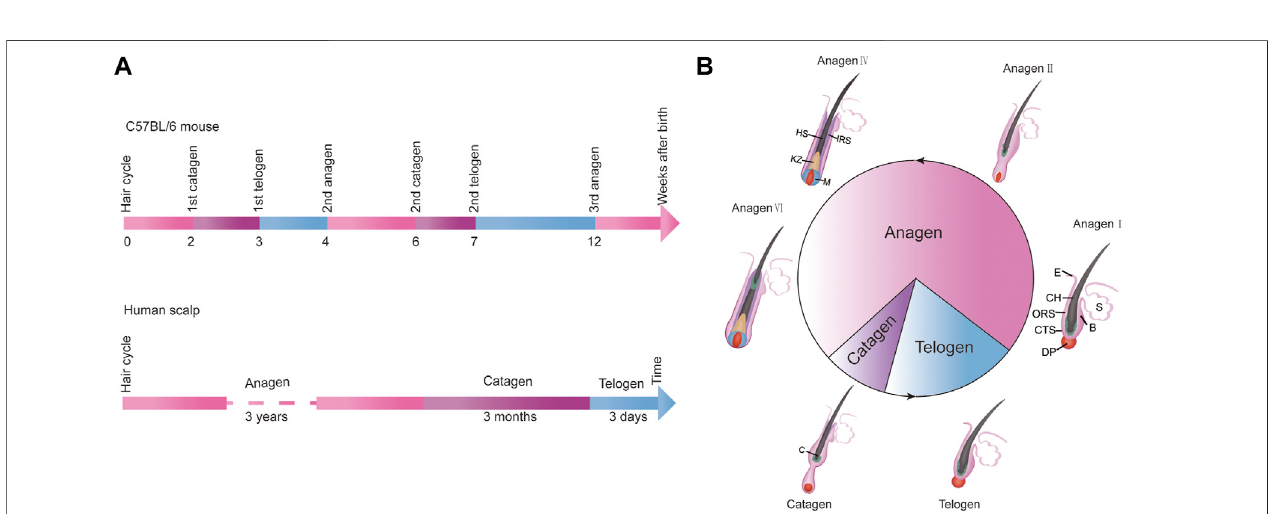
FIGURE 2 | Morphogenesis and timing of hair follicle during mouse embryonic development. The most important developmental stages of mouse pelage hair follicles are divided into induction, organogenesis and cytodifferentiation.